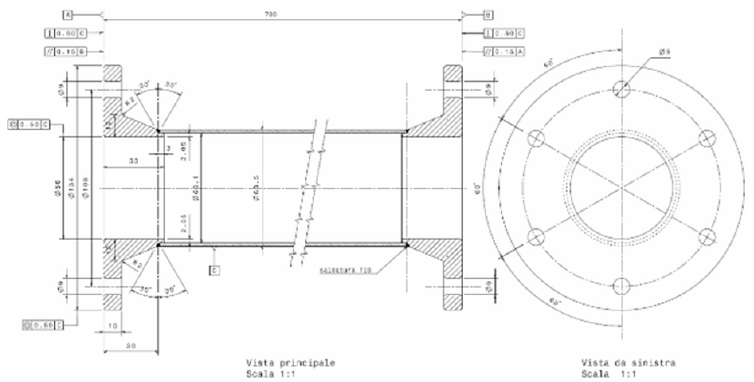
Figura 1: Geometria dell’albero di trasmissione oggetto di